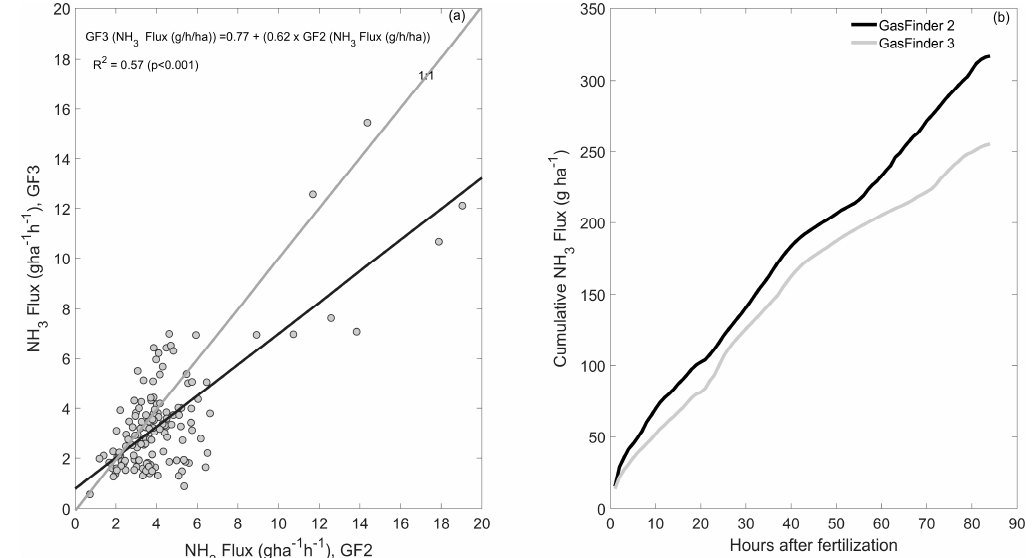
Figure 9. ( a ) Comparison of the hourly averaged NH 3 flux determined by the bLS technique combined with the GasFinder 2 and GasFinder 3. The black line denotes the linear regression, and the gray line is the plot of 1:1. ( b ) Cumulative NH 3 emission calculated from hourly averaged NH 3 fluxes for both lasers.